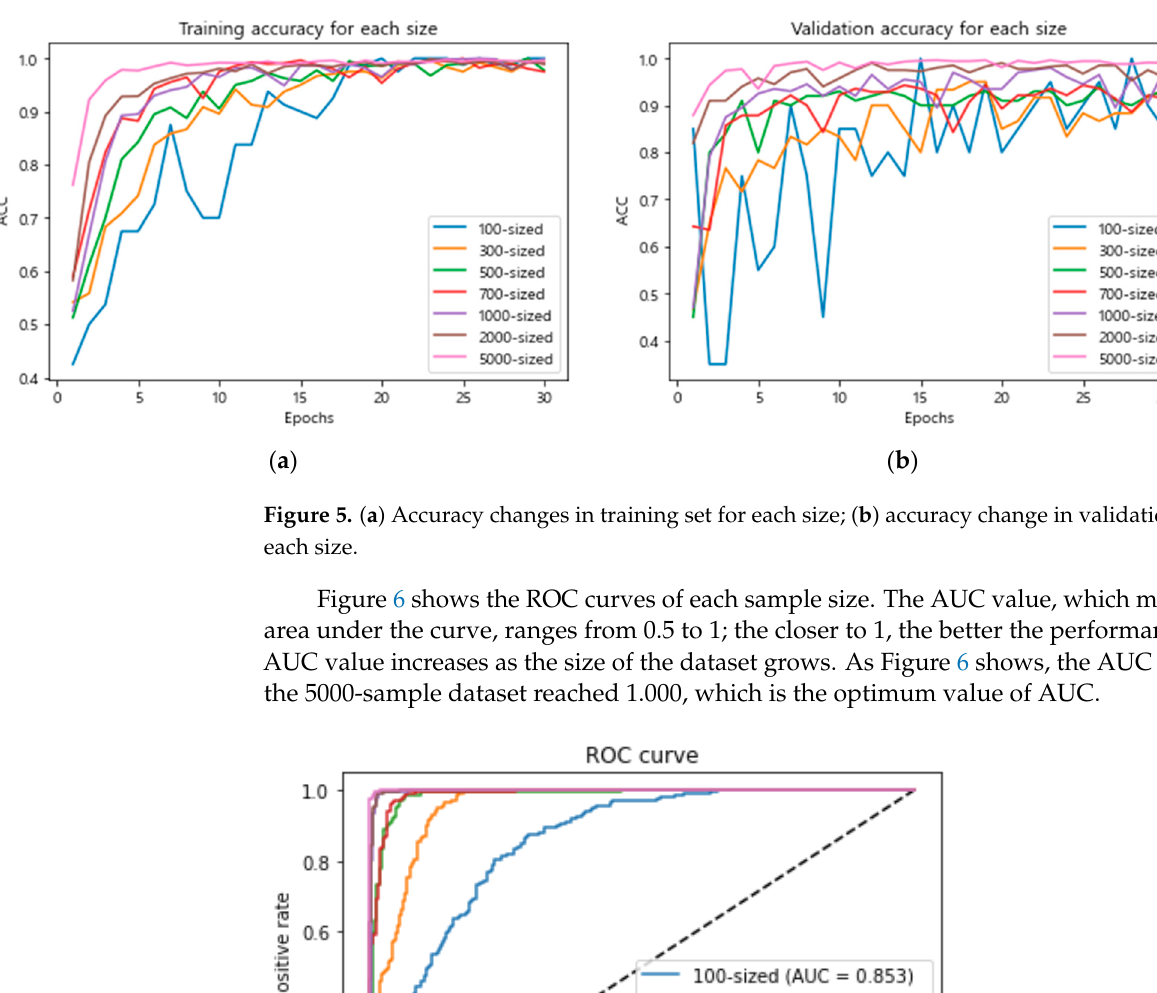
Figure 4. ( a ) Loss change in training set for each size; ( b ) loss change in validation set for each size.